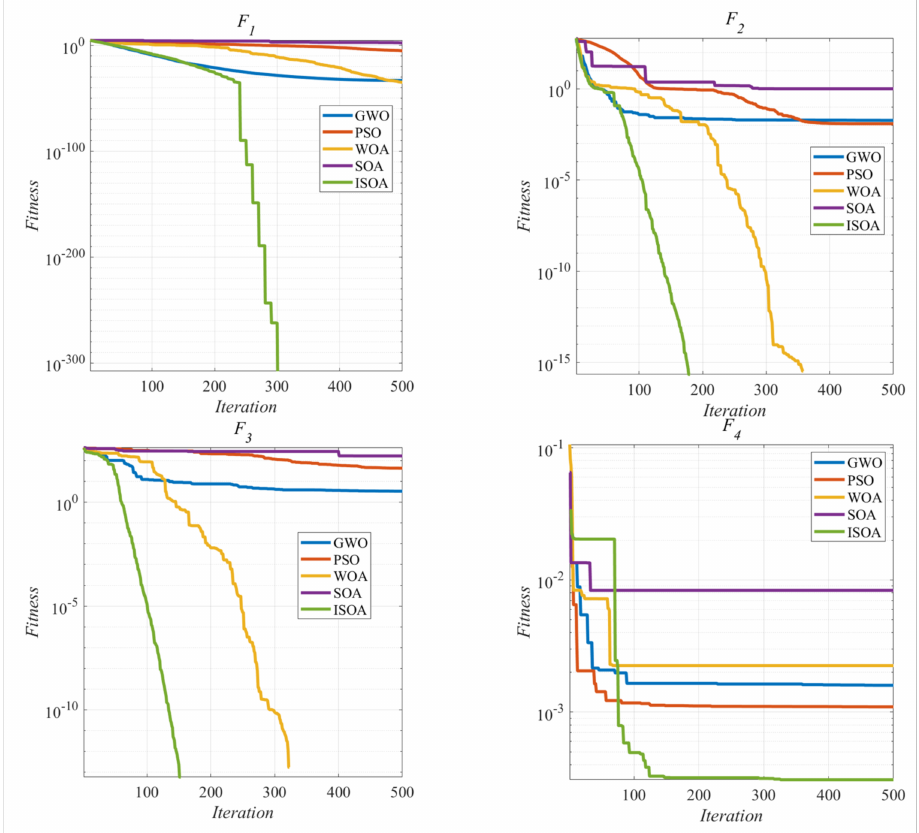
Figure 6. Benchmark function test results. Table 3. Benchmark function